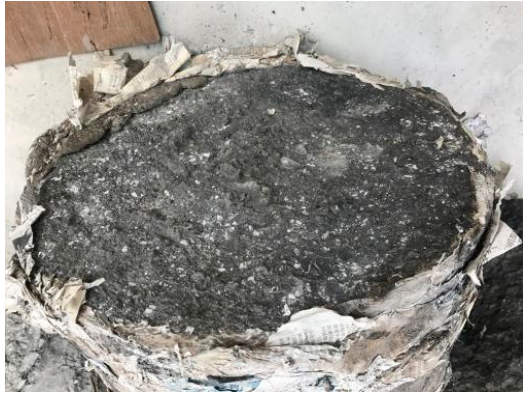
Figure 6. Specimen after test.